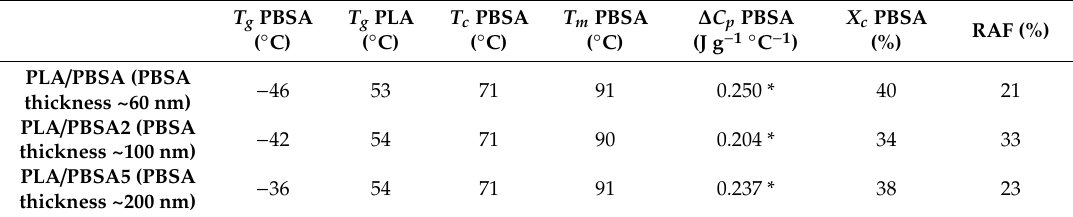
Table 5. Thermal properties of the neat and filled PLA / PBSA multilayer